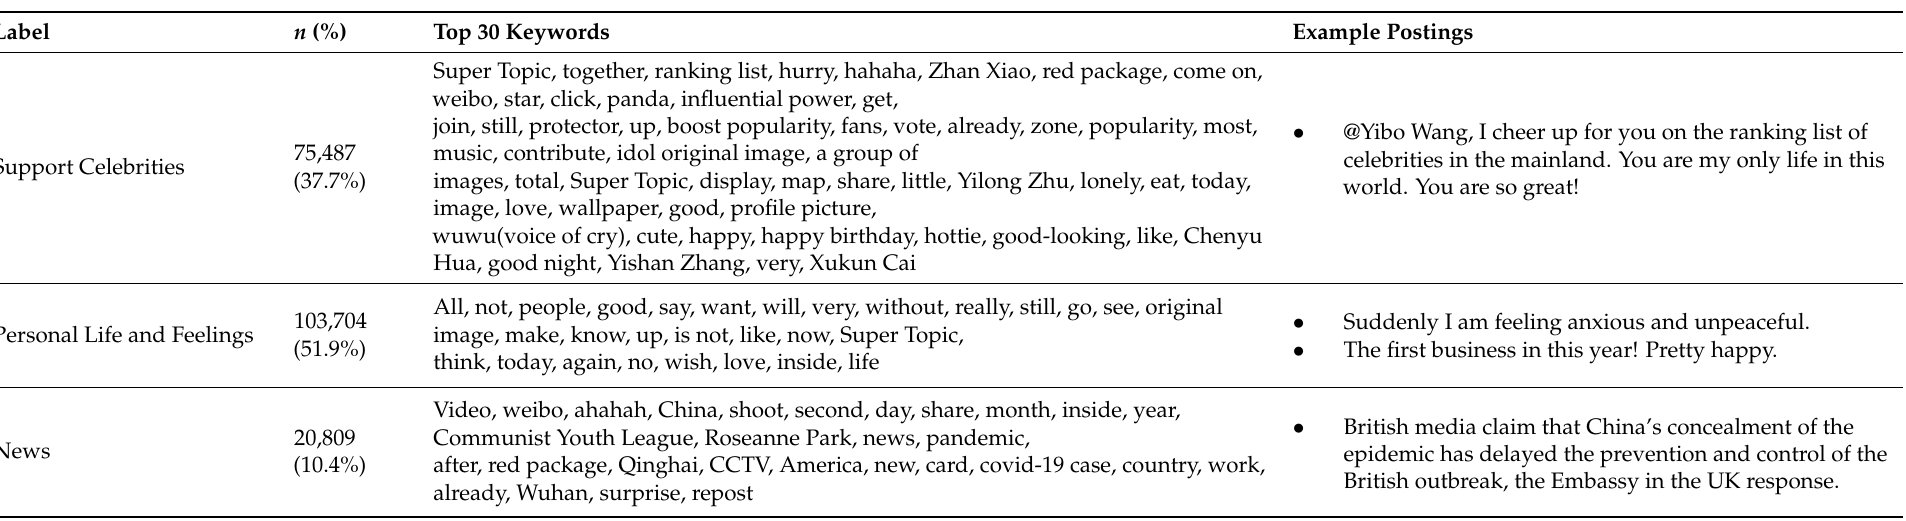
Table 2. Themes of postings from regular